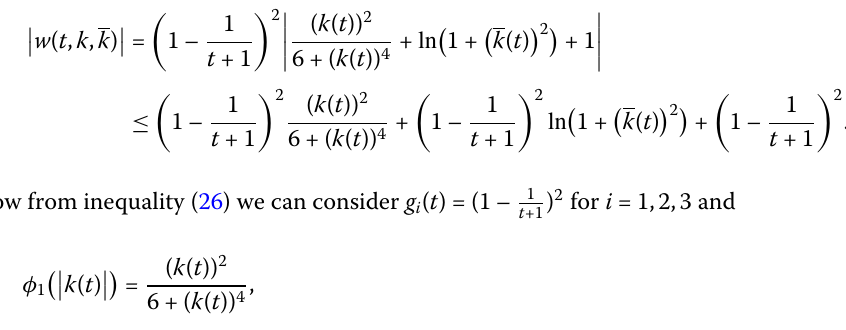
, 1 , 7 in Example 5 2 8